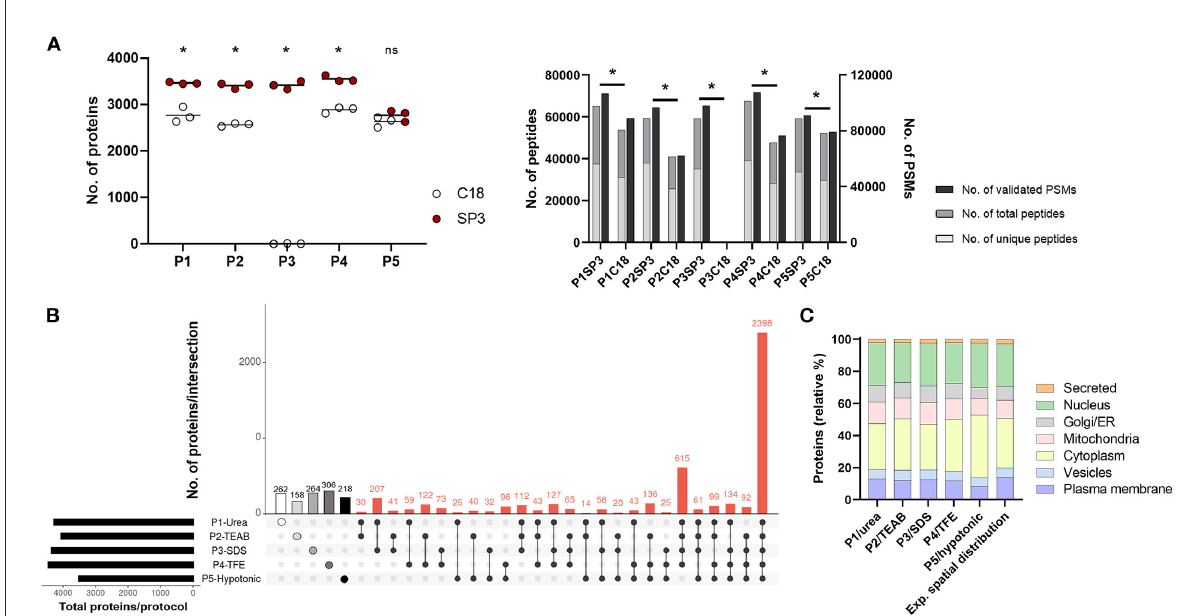
FIGURE2 Performance of P1-P5 cell lysis protocols combined with SP3 or C18 clean-up methods in 50,000 dTHP1 cells. Experiments were run in triplicate and depicted proteins were identified with at least 2 unique peptides. (A) Number of proteins (left panel), peptides (total and unique) and validated peptide spectrum matches (PSMs) (right panel) identified per procedure. (B) Attribute plot displaying the qualitative proteomic analysis of P1–P5 combined with SP3. Here, maximum proteome coverage (i.e., all proteins identified by any of the three replicates per protocol) was considered in the analysis. Each vertical bar shows unique protein numbers and corresponds to either a unique procedure (white-, light grey-, medium grey-, dark grey- and black-filled dots for P1-, P2-, P3-, P4-, and P5-SP3 combinations, respectively) or a set of procedures (black dots interconnected by lines). The bar chart on the bottom left side plots the total number of proteins identified per protocol. (C) Subcellular location distribution of proteins identified per protocol and expected spatial distribution for dTHP1 proteome (based on all protein datasets for this cell model). Protein numbers are expressed in relative percentages (%). The main subcellular location per protein was assigned according to UniProt database. Data used for the graph is collected in Supplementary Table 5. P1 , urea-; P2 , TEAB-; P3 , SDS-; P4 , TFE-; and P5